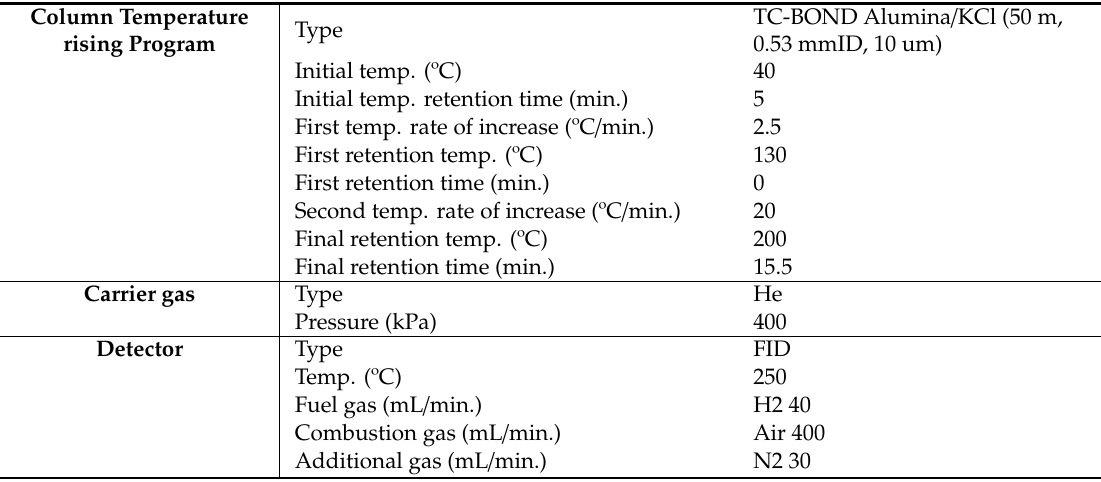
Table A2. Experimental setup of gas chromatography–mass spectrometry (GC-MS).